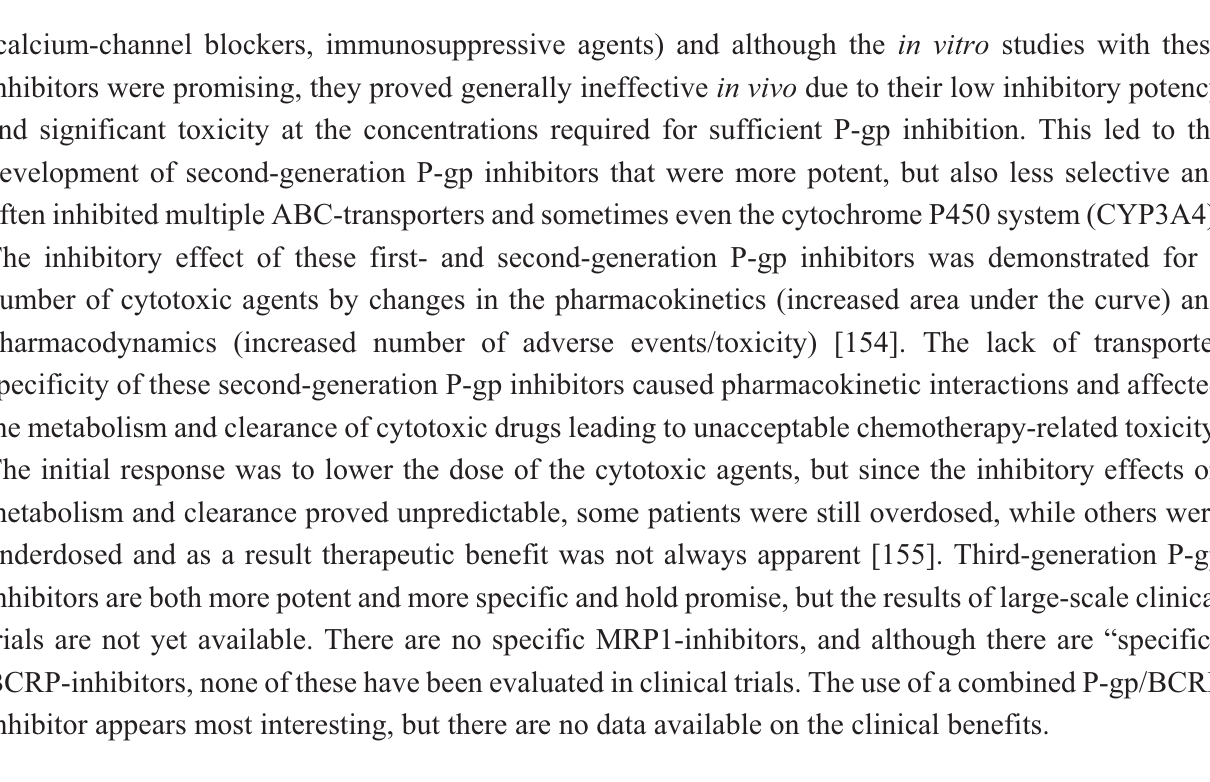
Table 8. Modulators of the ABC-transporters P-gp, MRP1, and BCRP [68].